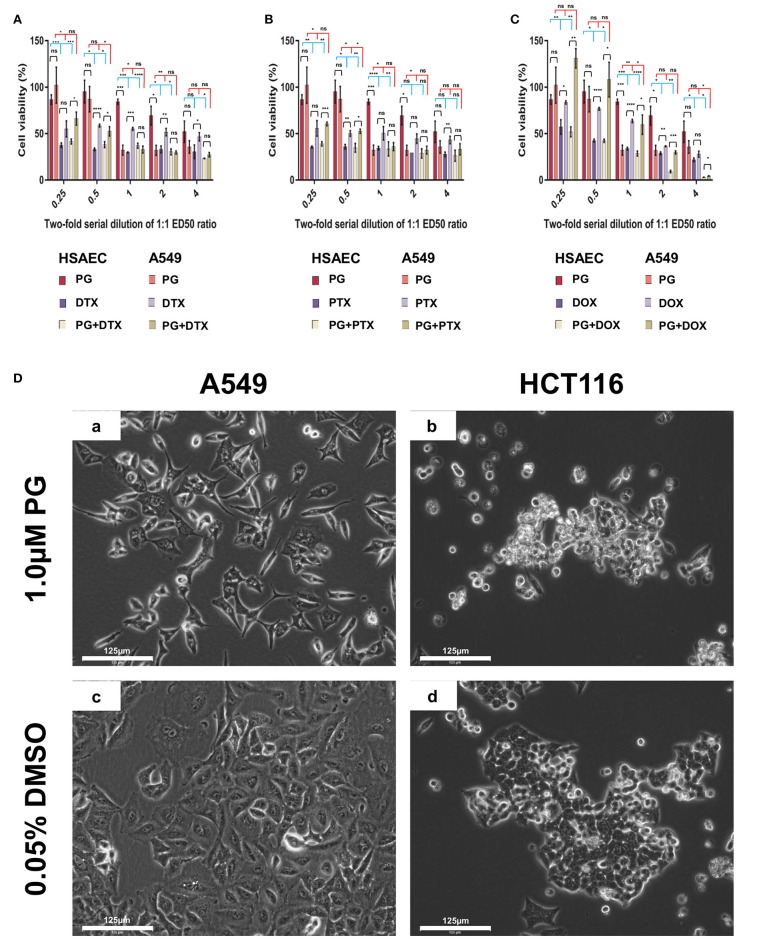
Cell viability of HSAEC and A549 cell measured by the MTT assay after 48-h of PG treatment (A–C). Effects of 1.0 μM PG on A549 and HCT116 cell morphology after 24 h treatment (Da–Dd). (A) PG, DTX, and PG+DTX. (B) PG, PTX, and PG+PTX. (C) PG, DOX, and PG+DOX. Bar graphs represent mean cell viability from biological triplicates (n = 3) while the black vertical lines on the bar tops represent standard deviation (SD). A Welch t-test was applied to the datasets; black horizontal lines compare drug effects between HSAEC and A549, blue lines compare within HSAEC, and red lines compare within A549 (*p < 0.05, **p < 0.01, ***p < 0.001, ****p < 0.0001, and “ns” is not significant). (Da) A549 and (Db) HCT116 were treated with 1.0 μM PG. (Dc) A549 and (Dd) HCT116 were treated with 0.05% DMSO as a negative control. Phase-contrast images were acquired at 20X magnification with the EVOS FL Auto 2 microscope. Images have not been enhanced. Scale bars represent 125 μm.